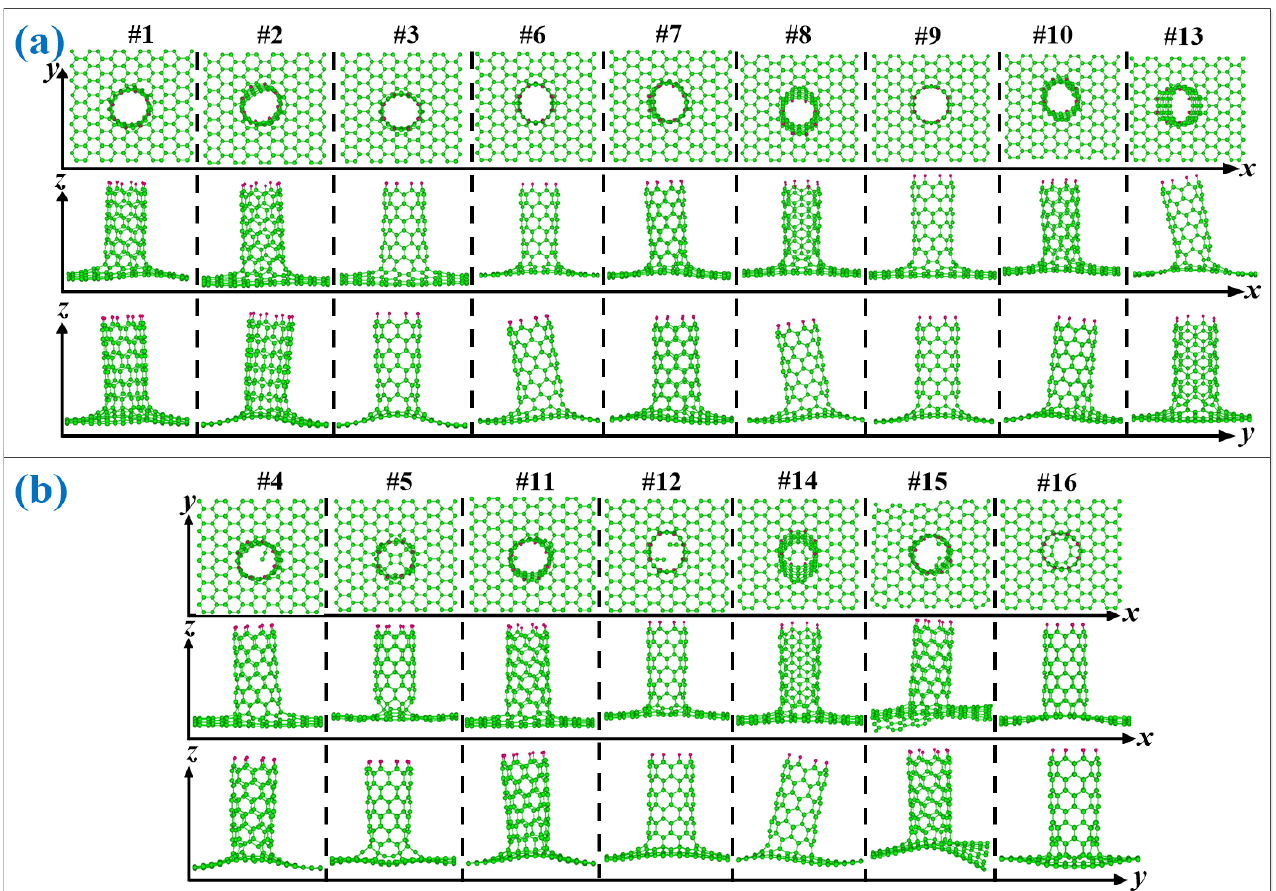
Figure 4. ( a ) Optimized nine seamless structures of (8,0)CNT-graphene for configurations of #1,#2,#3,#6,#7,#8,#9,#10,#13. ( b ) Optimized seven failed structures of (8,0)CNT96-graphene for configurations of #4,#5,#11,#12,#14,#15,#16. (8,0)CNT-graphene positions are described as the following. The maximum x-coor-